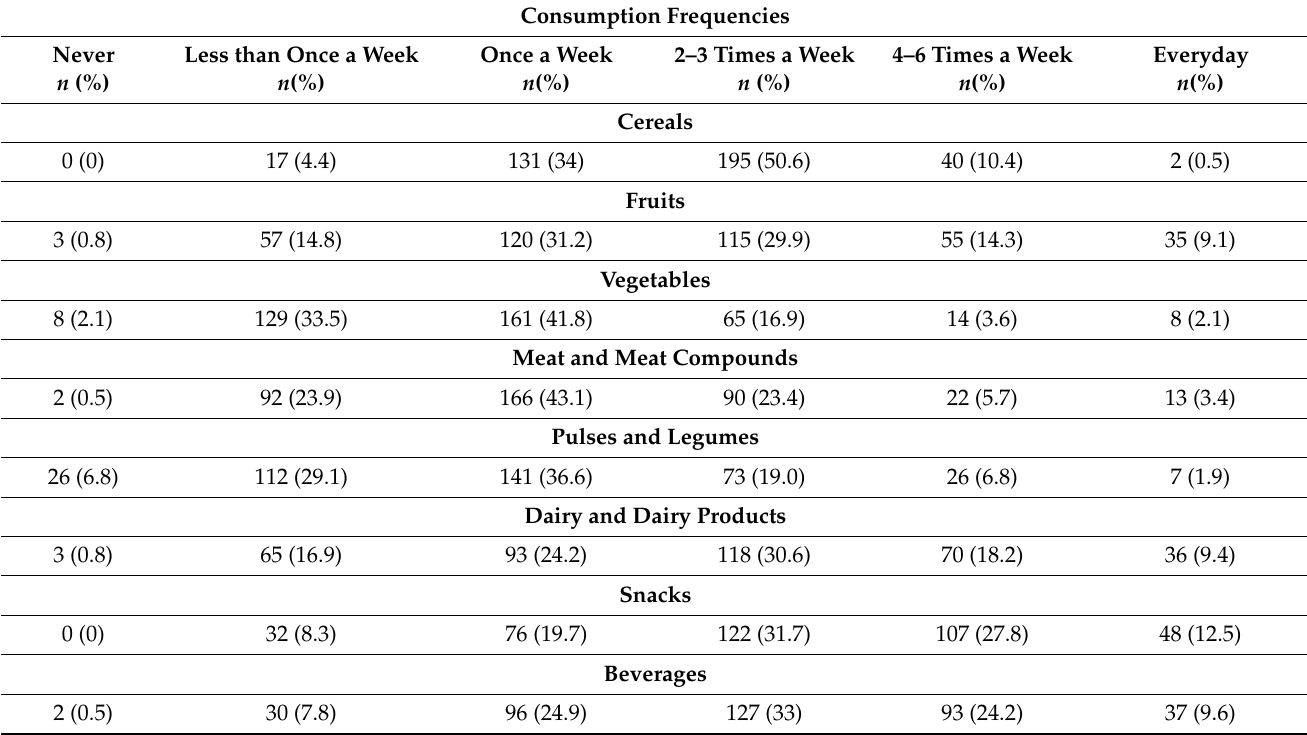
Table 2. Food Consumption Frequency Data for Children Enrolled In the Study ( N = 385).